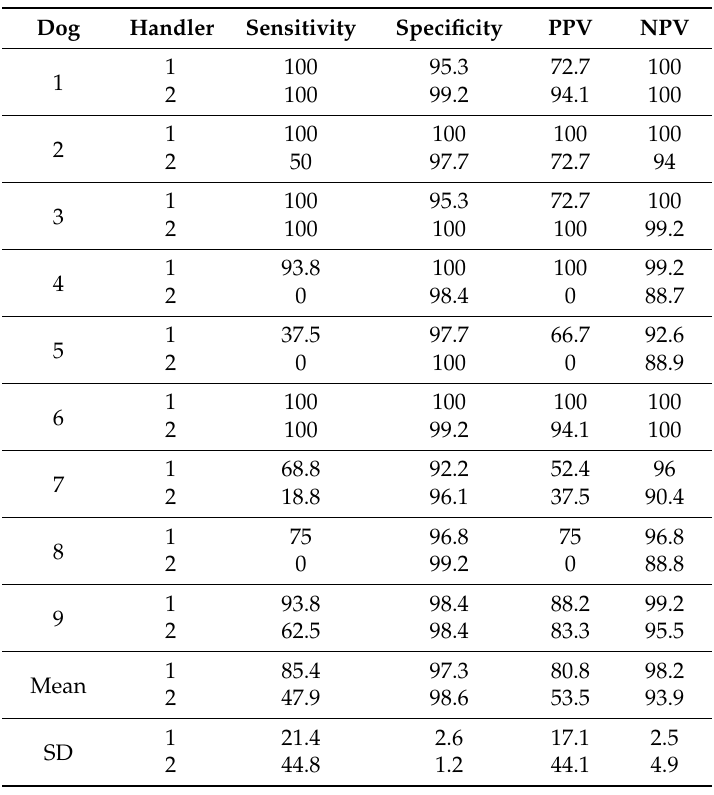
Table 2. Sensitivity, specificity, PPV and NPV scores with Handler 1 and Handler 2. Mean scores and standard deviations (SD) are also provided. Dogs 4, 5, and 8 did not work for Handler 2 as demonstrated by their scores of zero for sensitivity and